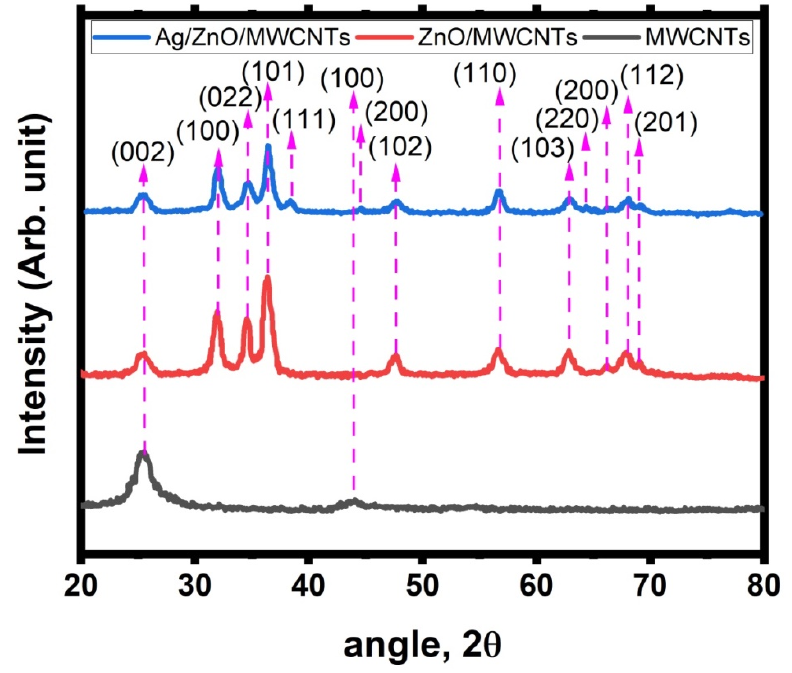
Figure 2. XRD diffractogram of MWCNTs, ZnO/MWCNTs, and Ag-doped ZnO/MWCNTs nano- composite.